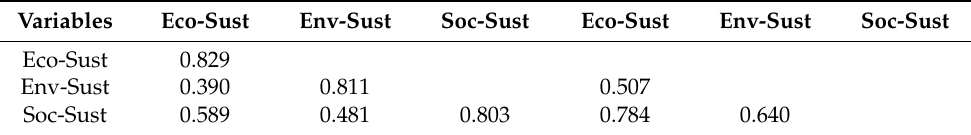
Table 4. Measurement of the first-order model (discriminant